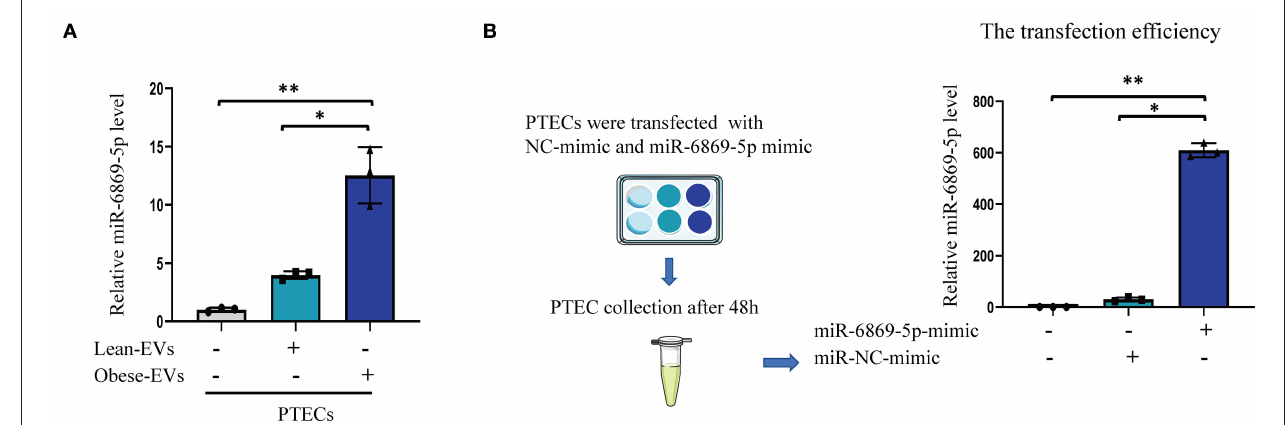
FIGURE 5 | Plasma EVs transport miR-6869-5p into PTECs in vitro. (A) Quantification of miR6869-5P levels in PTECs after co-culture with PBS, Lean-EVs, or Obese-EVs ( n = 3). (B) The transfection efficiency of the miR-6869-5p mimic was determined by RT-qPCR ( n = 3). Data are presented as mean ± SD; ** P < 0.001 vs. PBS, * P < 0.001 vs. Lean-EVs. EVs, extracellular vesicles; PTECs, Proximal tubular epithelial